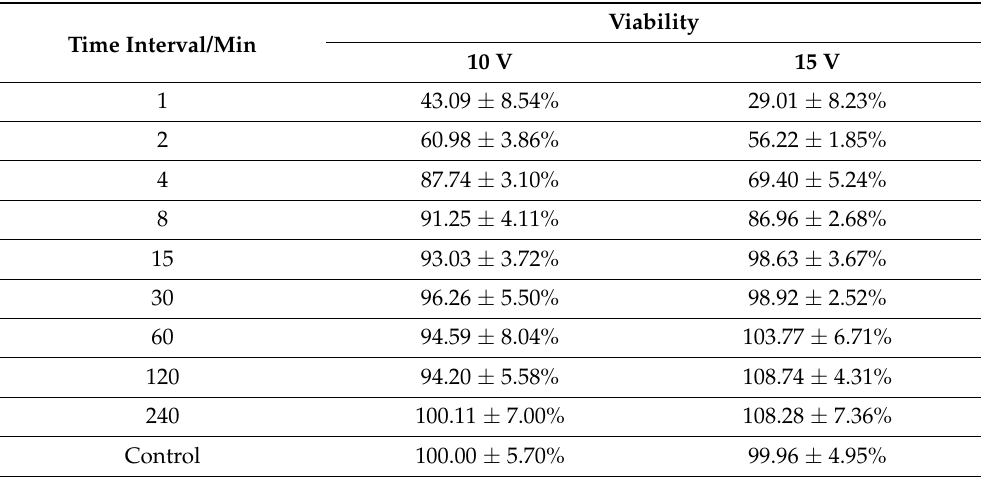
Table 4. The data of cell viability after 4 cycles of repeated nanostraw-electroporation under different time